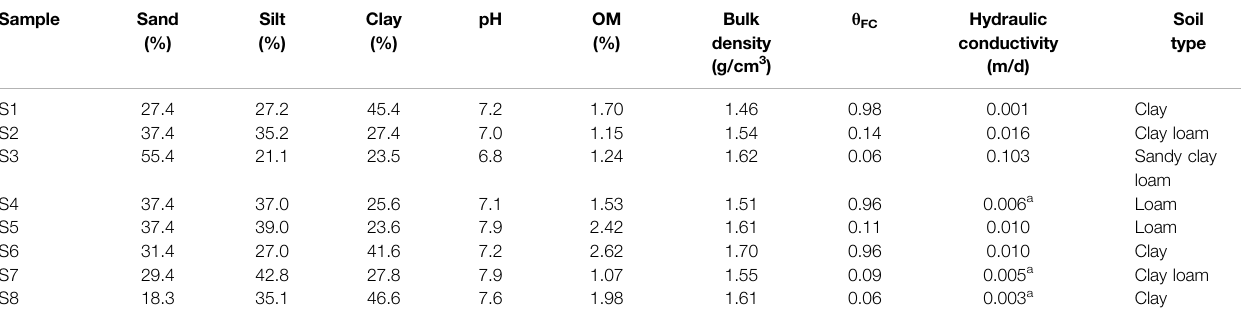
a Derived from Supplementary Table S4 . The values of δ 15 N at W12 and W4 were mostly higher than those at the other sampling points.